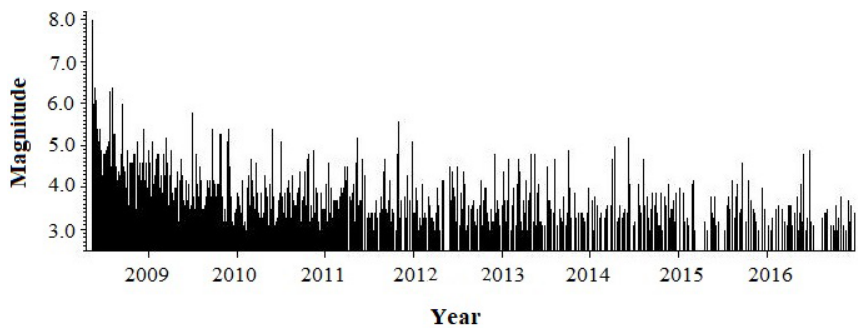
Figure 2. Series plot of the Wenchuan earthquake sequence with M ≥ 3 . 0 from 12 May 2008 to 31 December 2016.